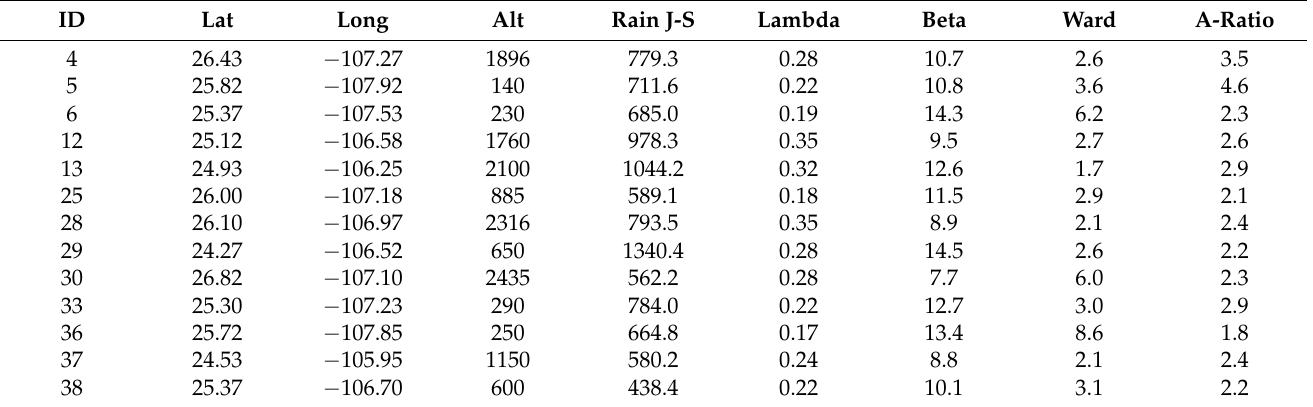
Table A3. Region III: Humid zone with Hewlettian hydrology at Sierra